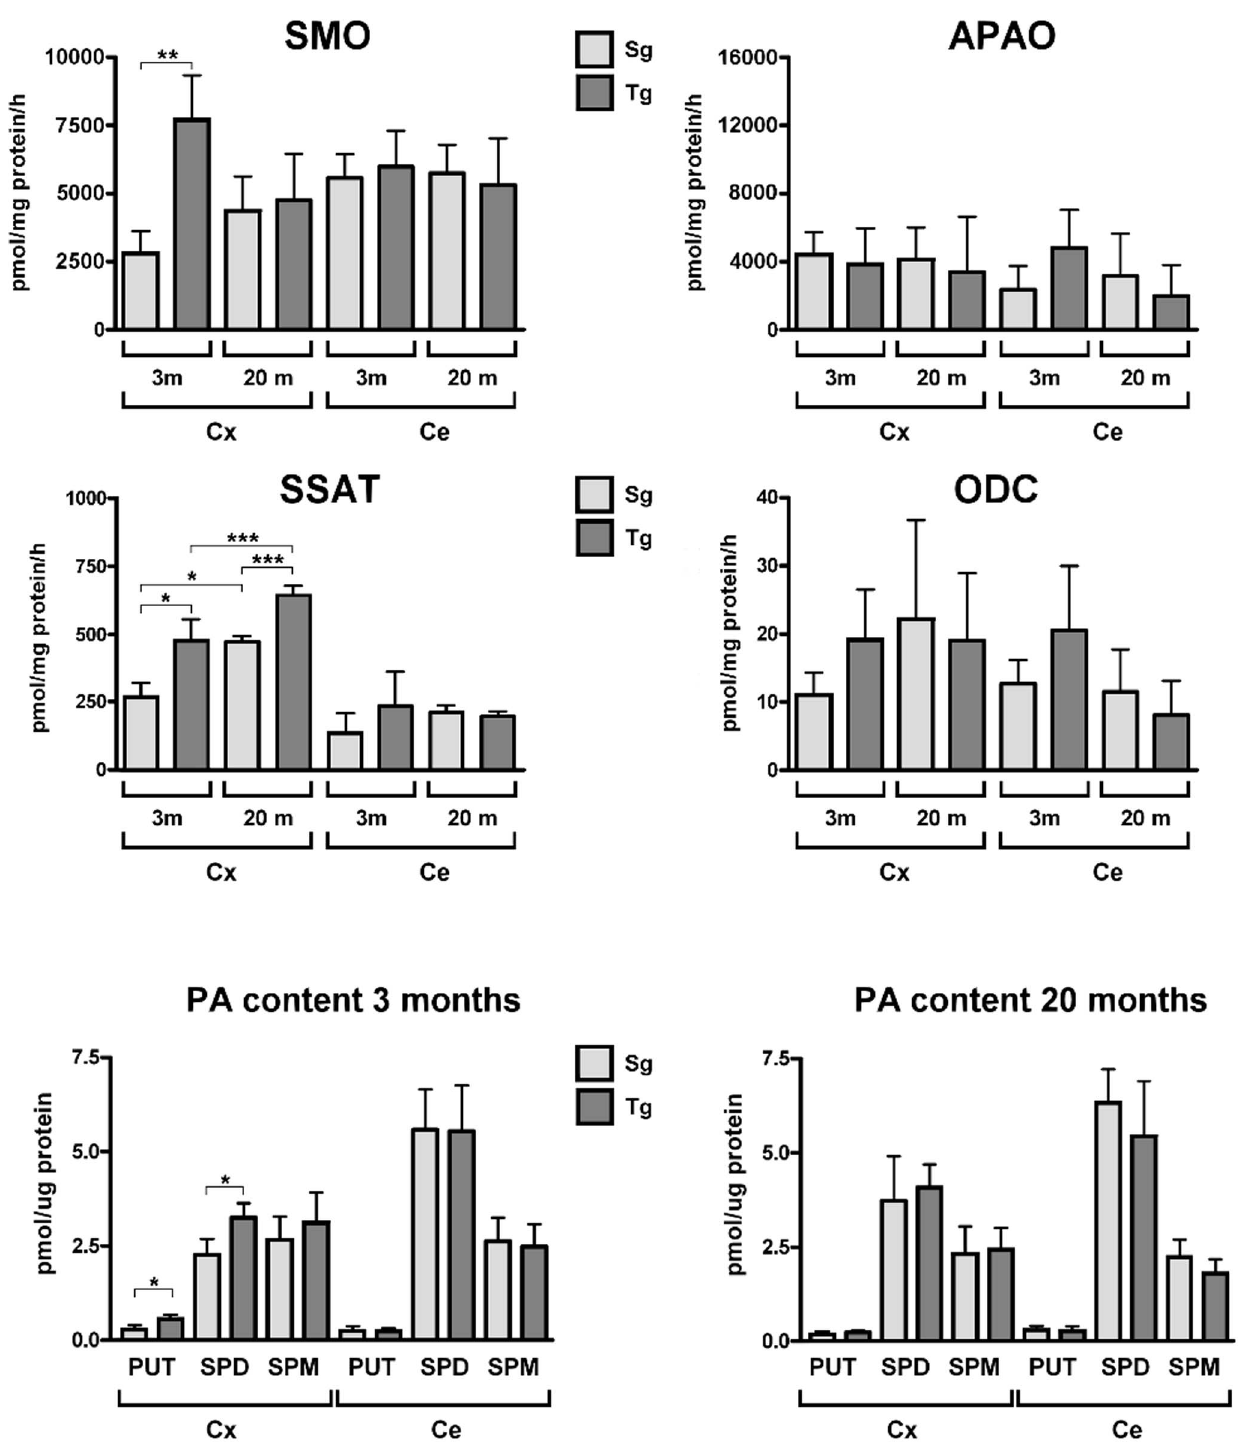
Figure 4. SMO, APAO, ODC and SSAT activities and PA content of Tg and Sg mice. Enzyme activities of SMO, APAO, ODC and SSAT and PA content from cortex and cerebellum of 3 (3 m) and 20 (20 m) months old mice were analyzed. The p values were measured with one-way ANOVA test and post-hoc test Bonferroni (*, p , 0.05; **, p , 0.01). Sg, syngenic mice; Tg, transgenic mice; Cx, cortex; Ce, cerebellum.